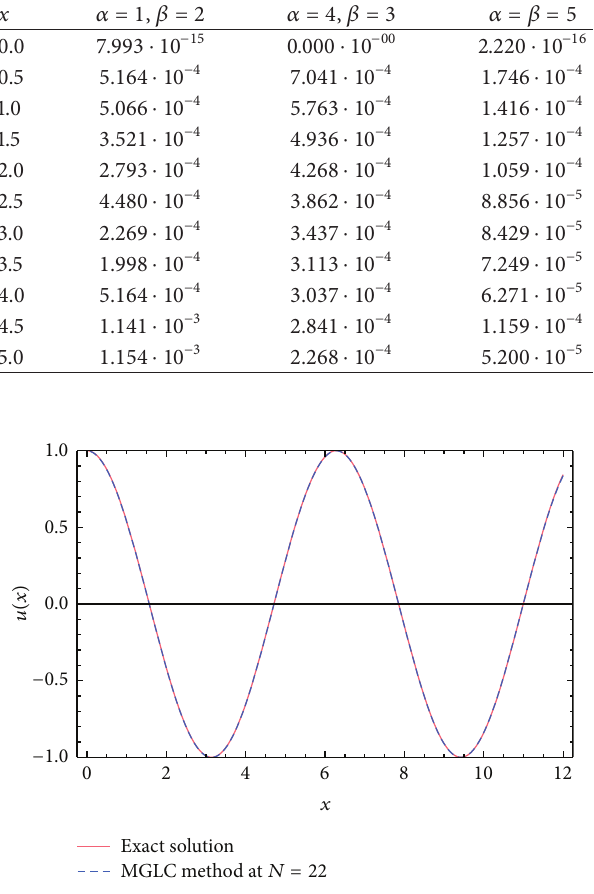
Figure 1: Graph of exact solution and approximate solution for 𝛼 = 4 , 𝛽 = 2 at 𝑁 = 22 for Example